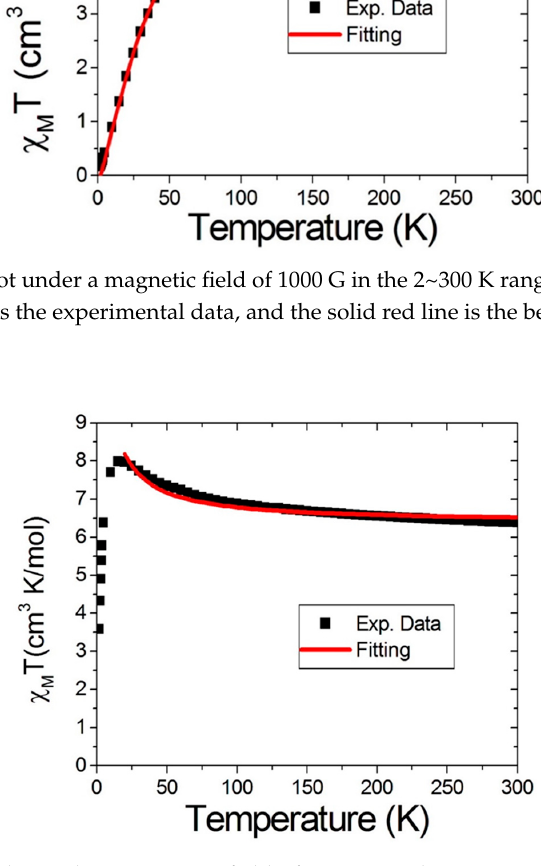
Figure 5. χ M T vs. T plot under a magnetic field of 1000 G in the 5~300 K range for compound 2 . The black squares represent experimental data, and the solid red line is the best fit to the data using Equation (1).